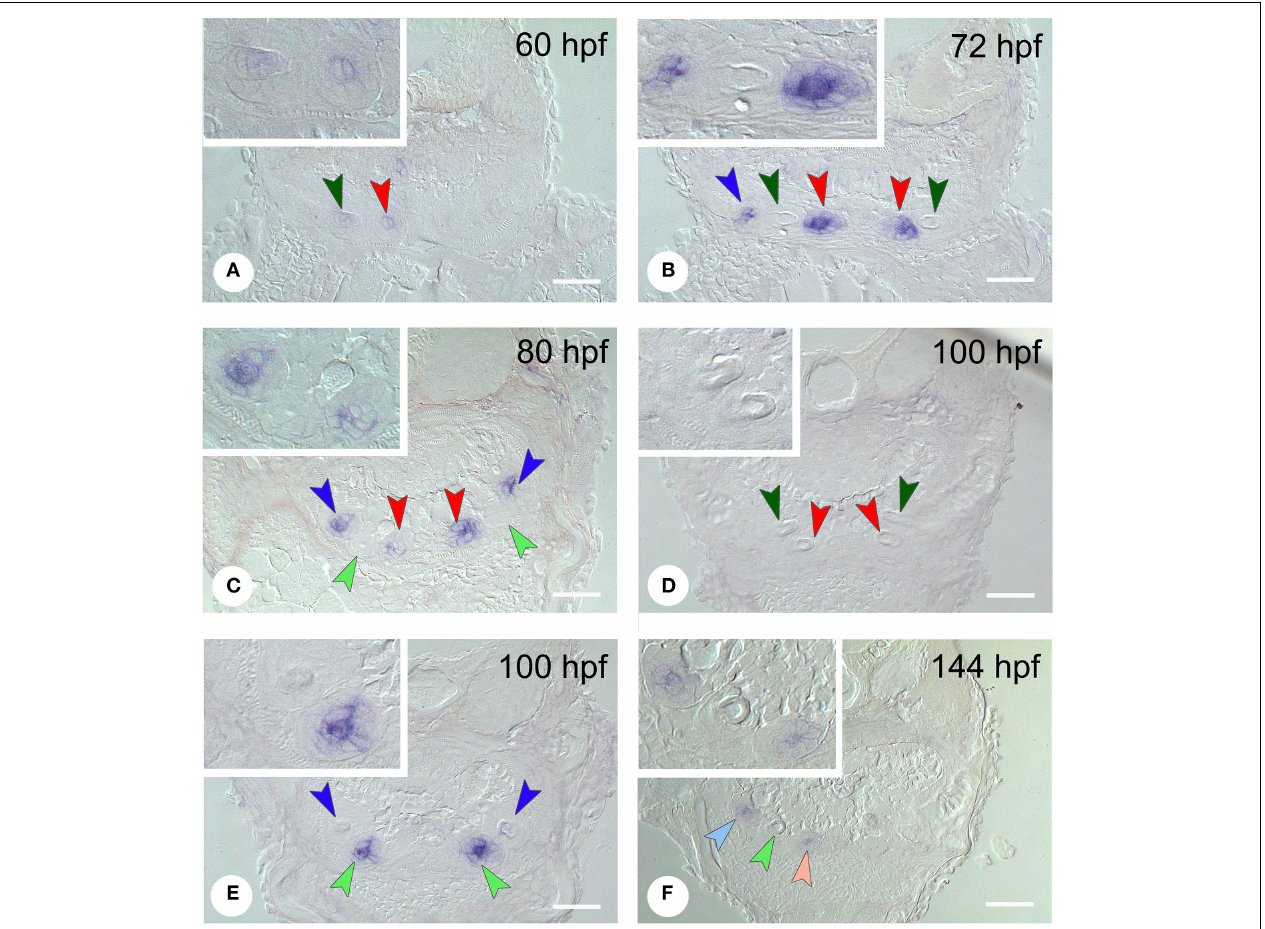
FIGURE 3 | Expression of dkk1 in different stages of development of first- and second-generation teeth. (A) 60hpf: weak mesenchymal expression in tooth 4V 1 , epithelial expression starts to be upregulated in 3V 1 ; (B) 72hpf: strong epithelial expression in 3V 1 and 5V 1 , but loss of signal in 4V 1 ; (C) 80hpf: start of formation of 4V 2 showing no signal yet; epithelial signal is weakening in 3V 1 and 5V 1 ; (D,E) 100hpf; dkk1 is now downregulated in all first-generation teeth [3V 1 and 4V 1 in (D) , 5V 1 in (E) ], whilst the gene is upregulated in the first replacement tooth (4V 2 ); (F) 144hpf: expression in the two next second-generation teeth, 3V 2 and 5V 2 .